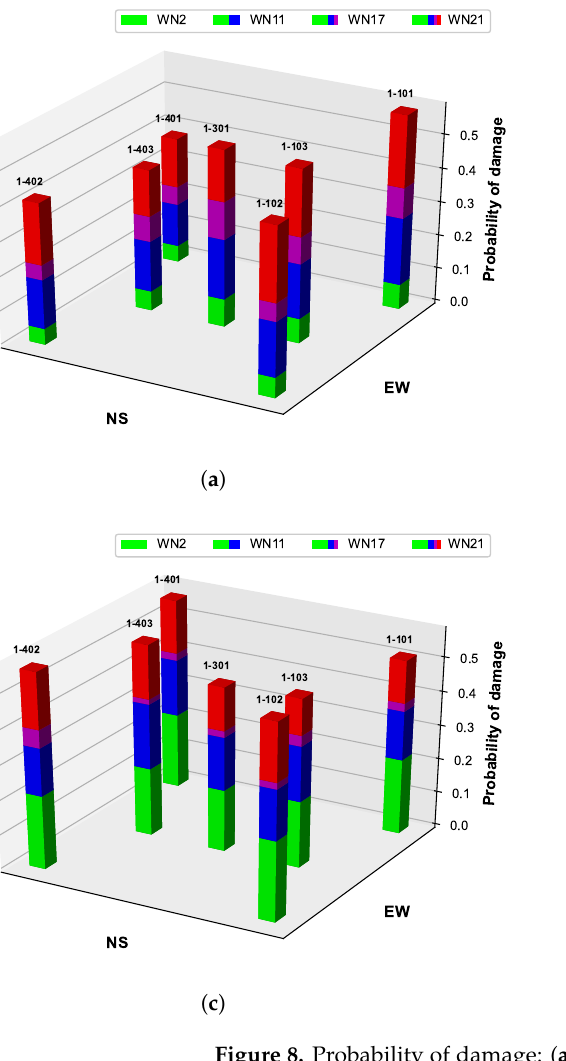
Figure 8. Probability of damage: ( a ) first floor (Seq2Seq model); ( b ) roof (Seq2Seq model); ( c ) first floor (baseline model); and ( d ) roof (baseline model). Table 4. Summary of damage